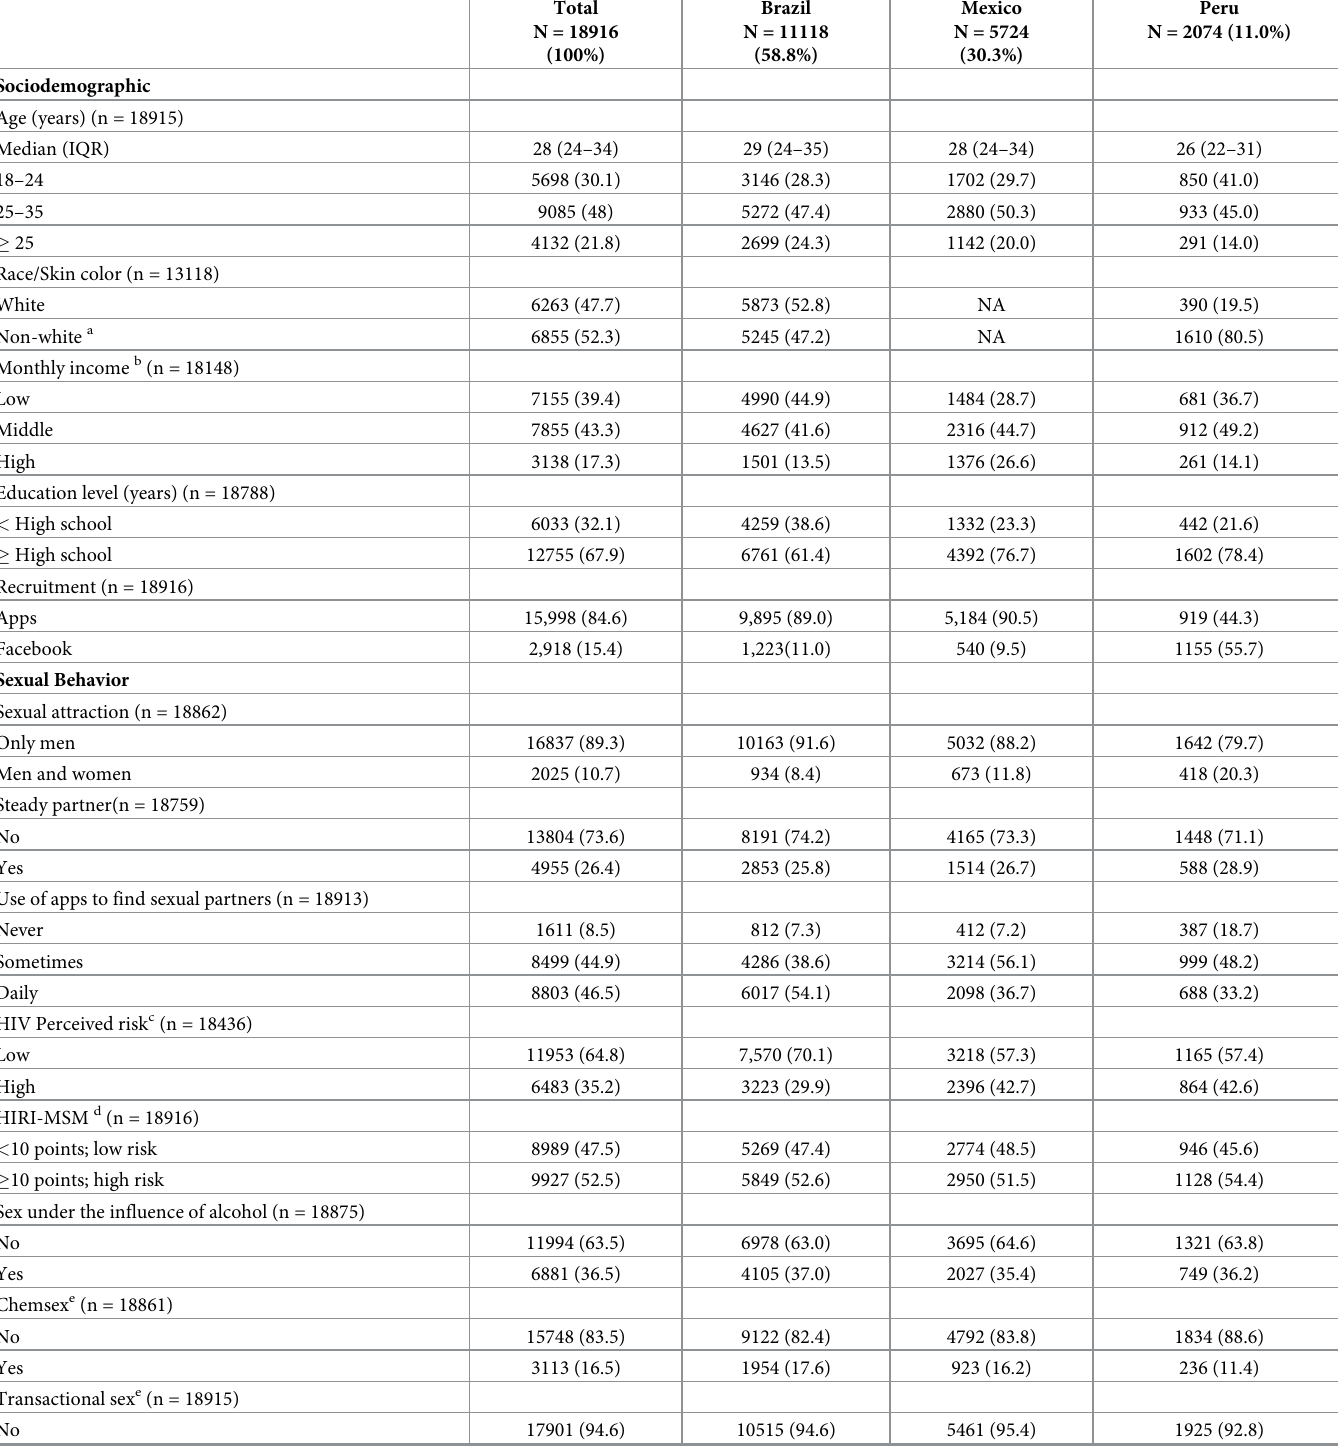
Table 1. Sociodemographic and Sexual Behavior of MSM from Brazil, Mexico, and Peru,